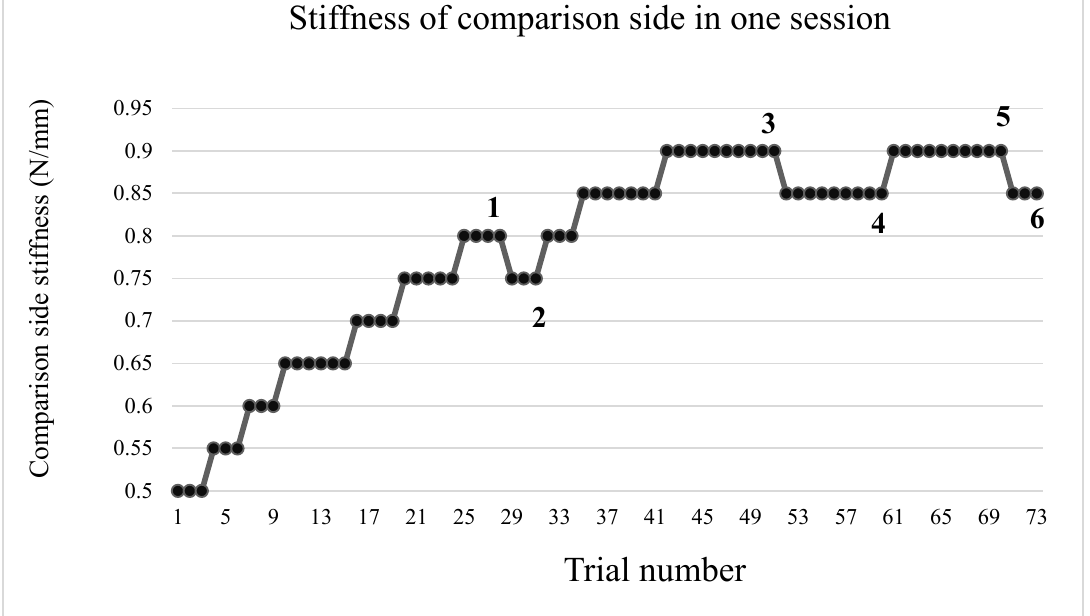
Figure 5. Actual sample participant data (reversals are numbered).